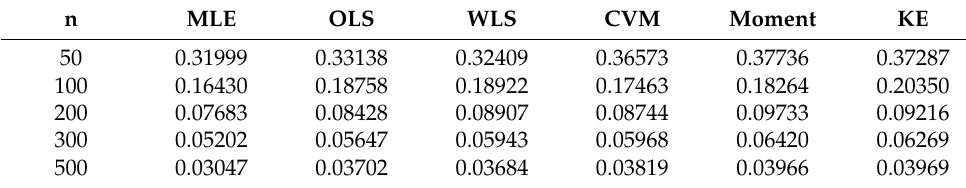
Table 3. MSEs under β =